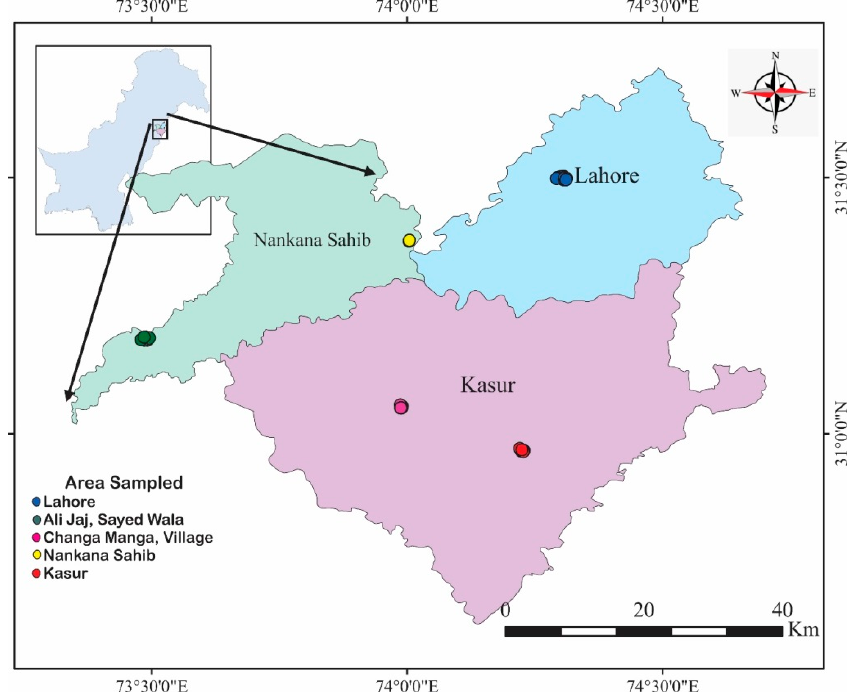
Figure 1. Map of Lahore and its adjoining areas with five sampling